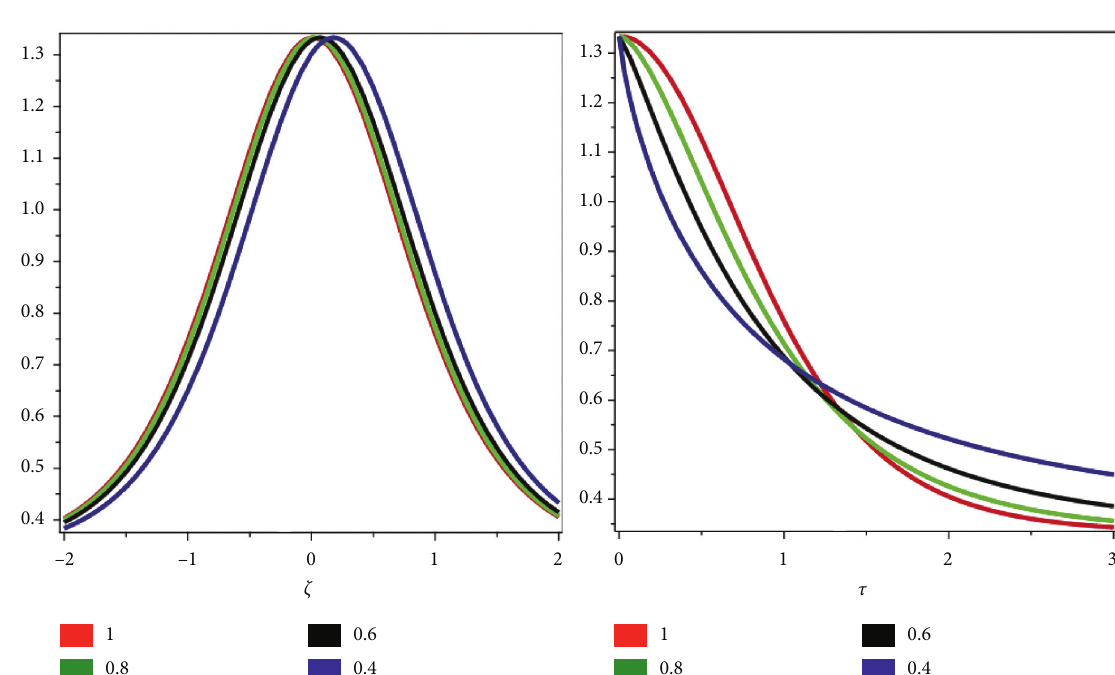
Figure 2: The fractional order ρ of Example 1 with respect to ζ and τ